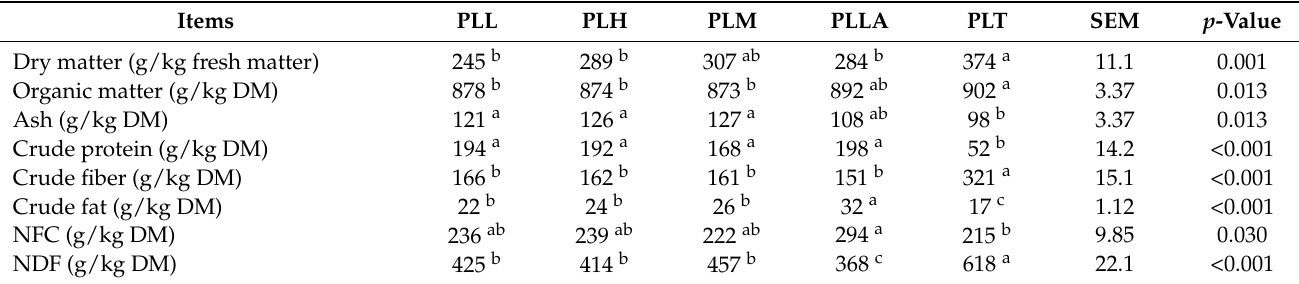
Table 1. Chemical composition of Paulownia leaves with lower concentration of bioactive components (PLL), Paulownia leaves with high concentration of bioactive components (PLH), Paulownia leaves with medium concentrations of bioactive components (PLM), Paulownia leaves lamina (PLLA) and Paulownia twigs